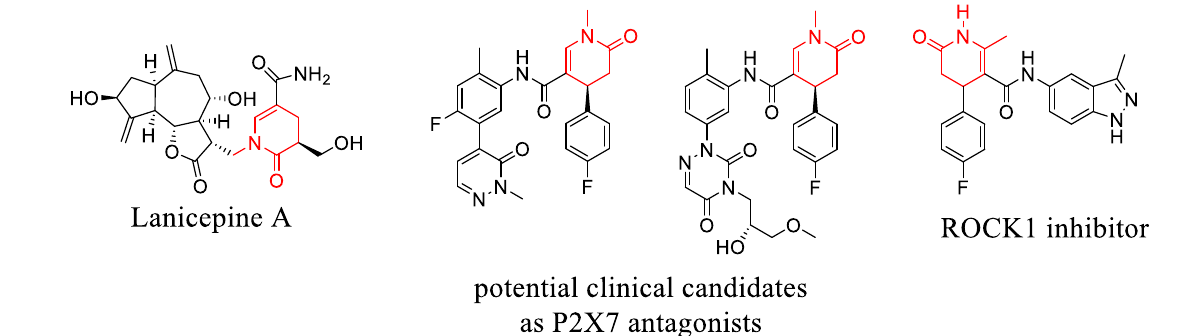
Figure 1. Natural and synthetic biologically active